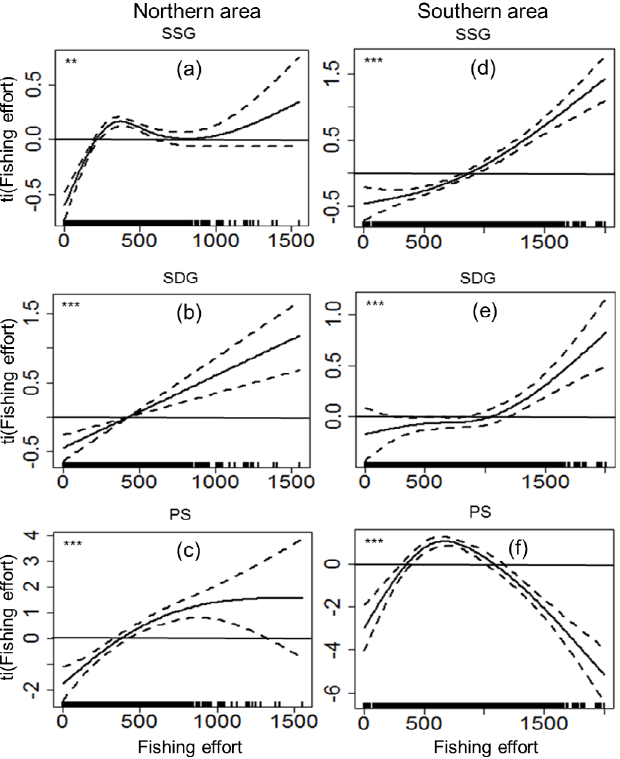
Fig. 4. Estimated smooth curves obtained by the GAM applied to landings of Sardinella aurita in the northern area ( fi rst row) and the southern area (second row): surface-set gillnet (SSG, a and d); surface-drift gillnet (SDG, b and e) and purse seine (PS, c and f). Dashed lines represent two standard error boundaries around the covariate main effects. Signi fi cance codes: (cid:1)(cid:1)(cid:1) 0.001; (cid:1)(cid:1) 0.01; (cid:1) 0.05. The x -axis shows the density of points for each covariate and the y -axis re fl ects the relative importance of each covariate.